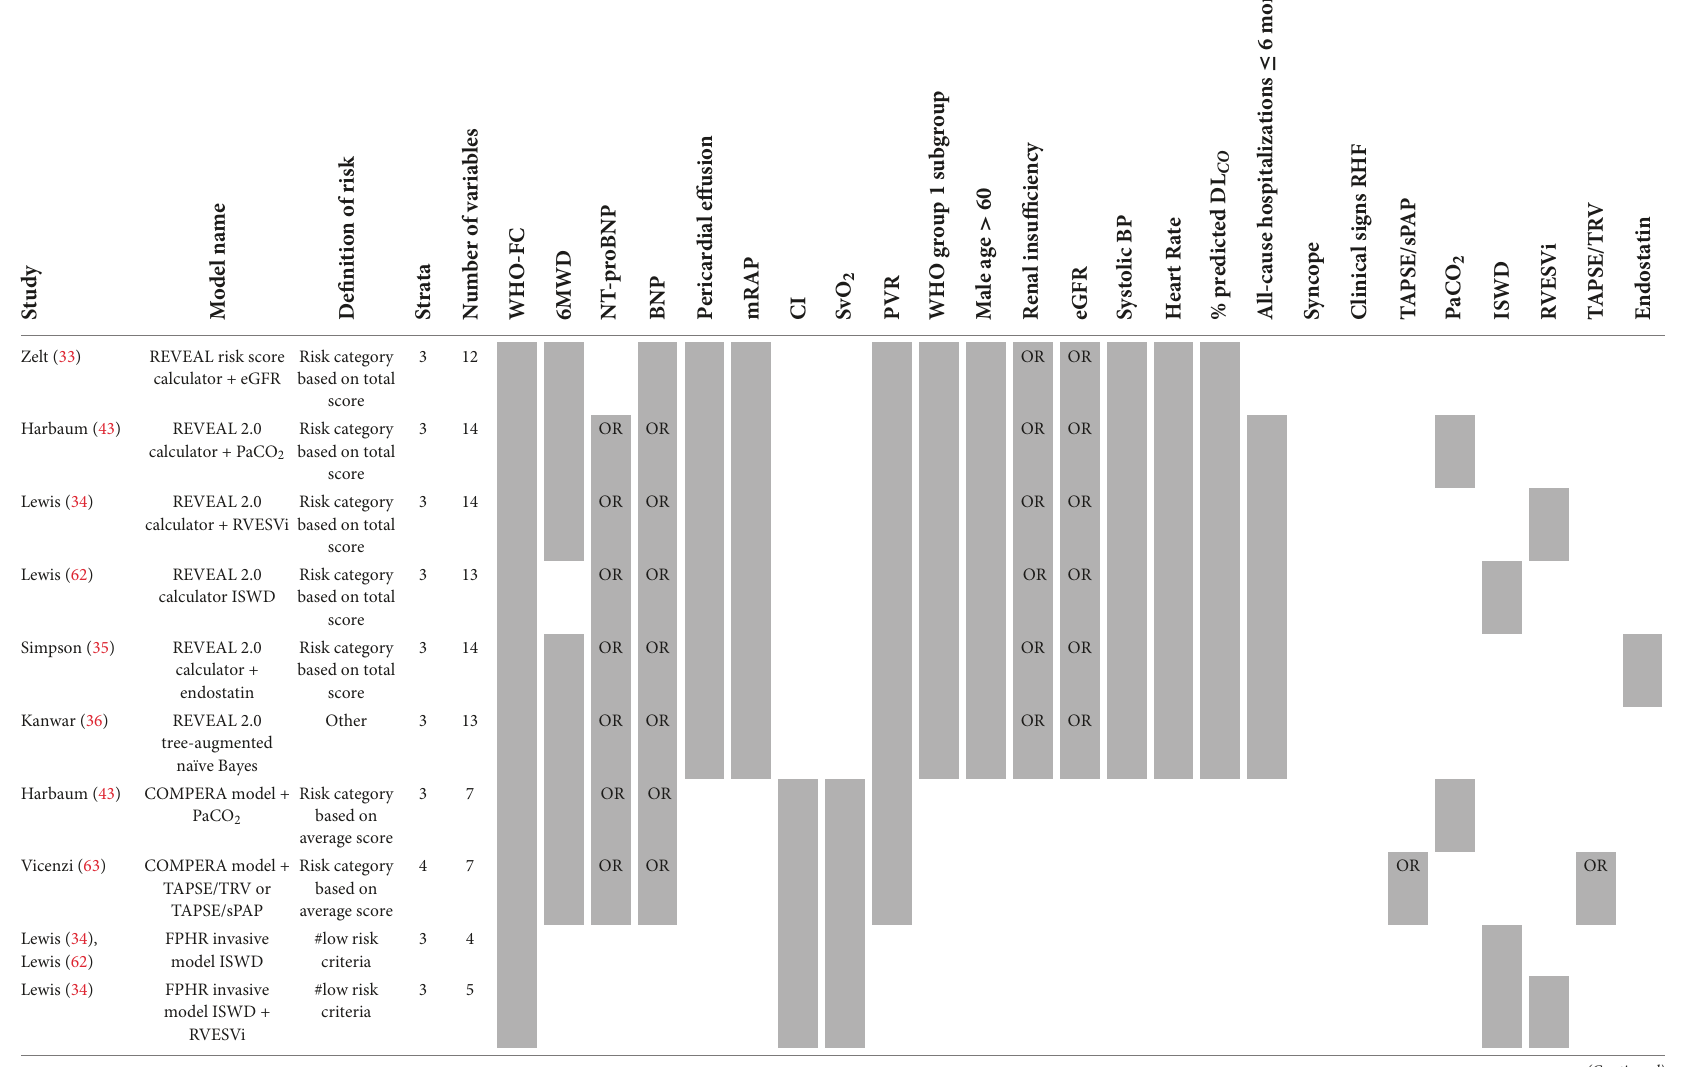
TABLE 5 Variables used in REVEAL and ESC/ERS 2015 guideline-based risk stratification models: enhancement